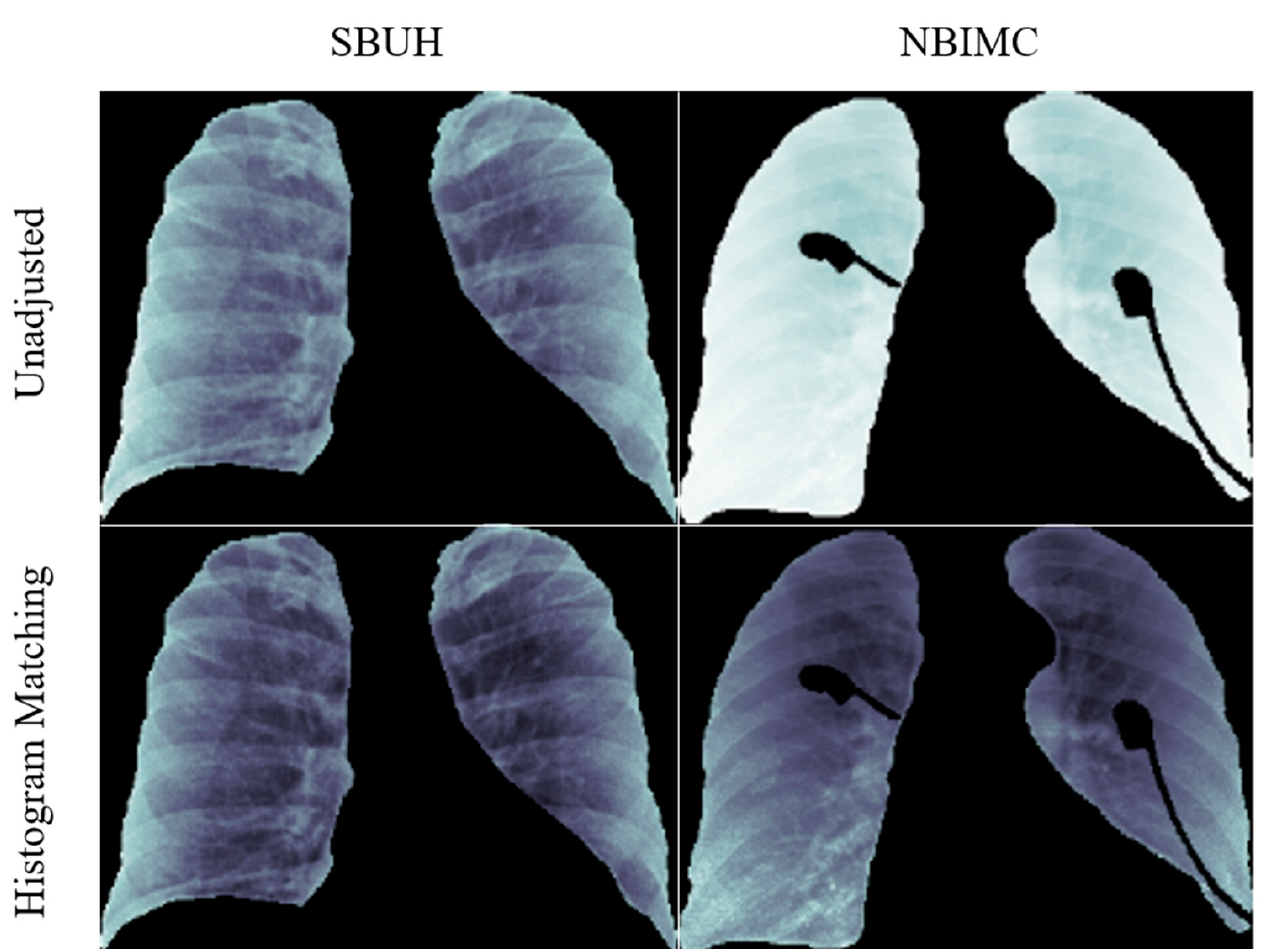
Figure 5. Results of histogram matching. Displayed are the results of HM preprocessing on CXR images from SBUH and NBIMC.